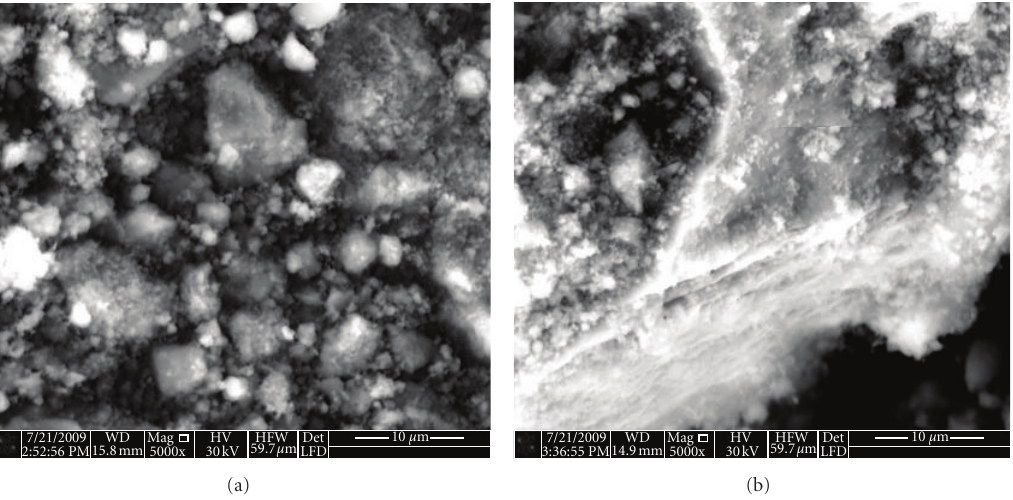
Figure 3: (a) and (b) Morphologies of HA powder particles after one hour of milling with W p : W b = 1 : 40.